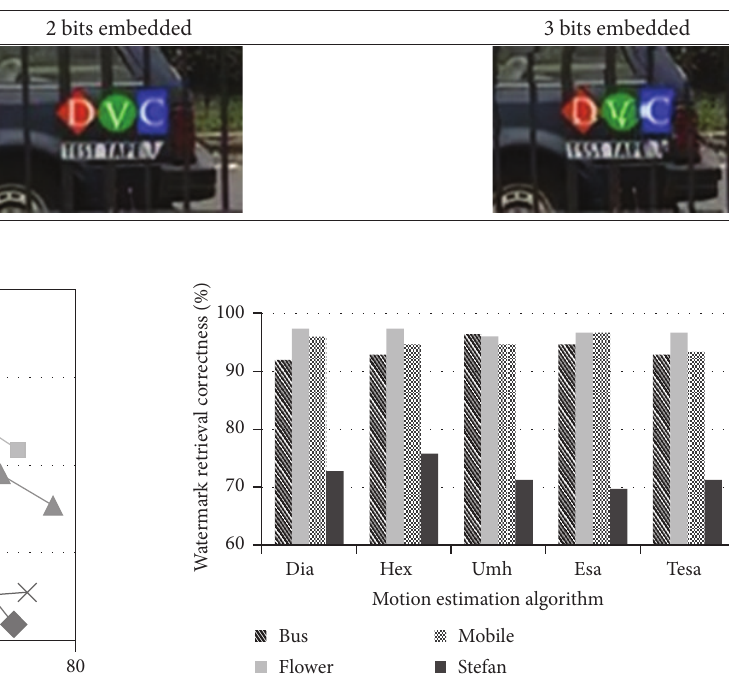
Figure 20: Watermark correctness rate after recoding with different motion estimation algorithms.